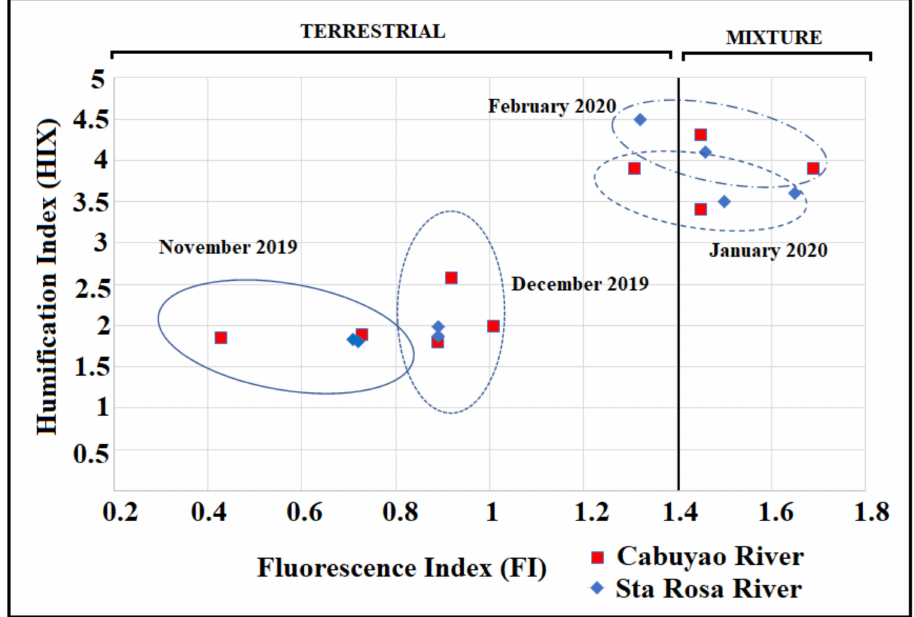
Figure 6. Index distributions of FI vs. HIX from November 2019 to February 2020 in SR and CR. FI values from November 2019 showed the lowest values among all samples. They range from 0.40 to 0.89. In December 2019, the FI values range from 0.89 to 1.01. All samples collected from November 2019 and December 2019 were terrestrially derived DOM